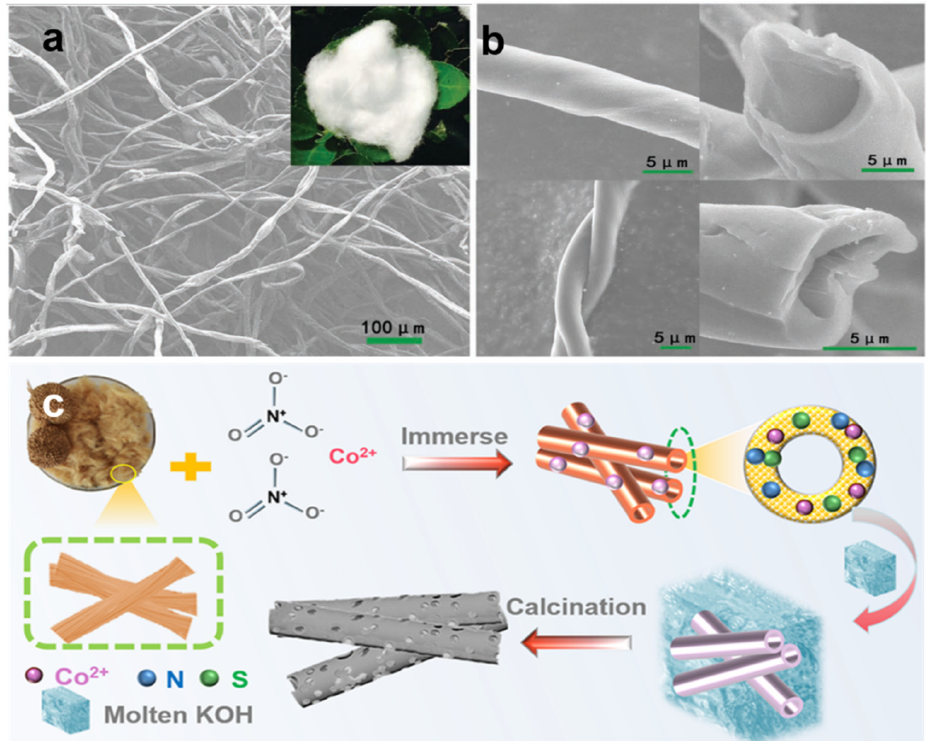
Figure 3. ( a ) SEM image and photograph of cotton. ( b )The magnified SEM images of the carbonized cotton with the detailed structure information. Reprinted with permission from Ref. [46]. Copyright 2017 Wiley-VCH. ( c ) Illustration of the preparation process of the cross-linked porous sample. Reprinted with permission from Ref. [79]. Copyright 2021 American Chemical Society.